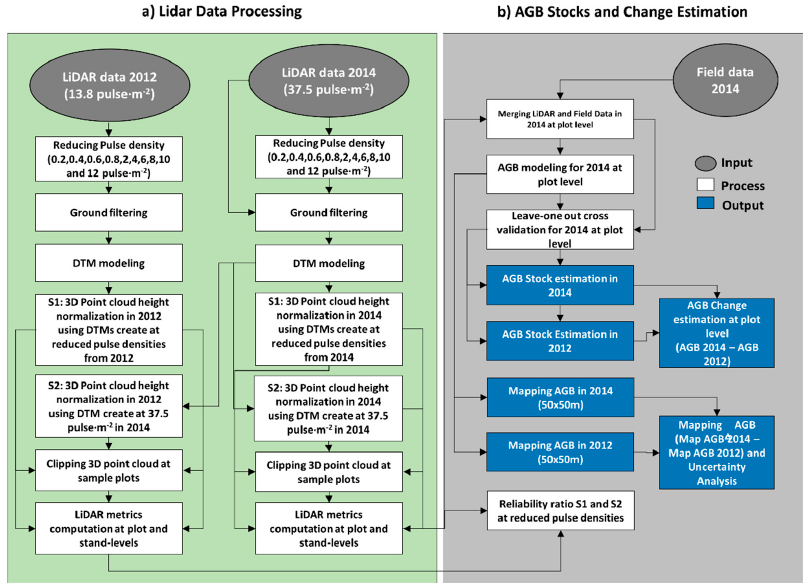
Figure 3. Flowchart of the lidar data processing for AGB stocks and AGB change estimation in tropical forest. The green panel to the left shows the lidar data processing ( a ) and the gray panel to the right shows the AGB stocks and change estimation steps ( b ).